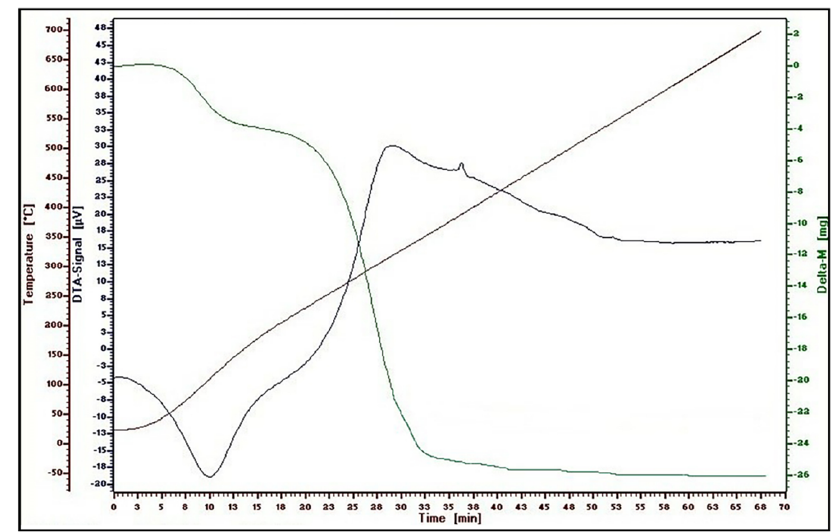
Figure 12. TG and DTA curves of the wood sample from the upper cover.